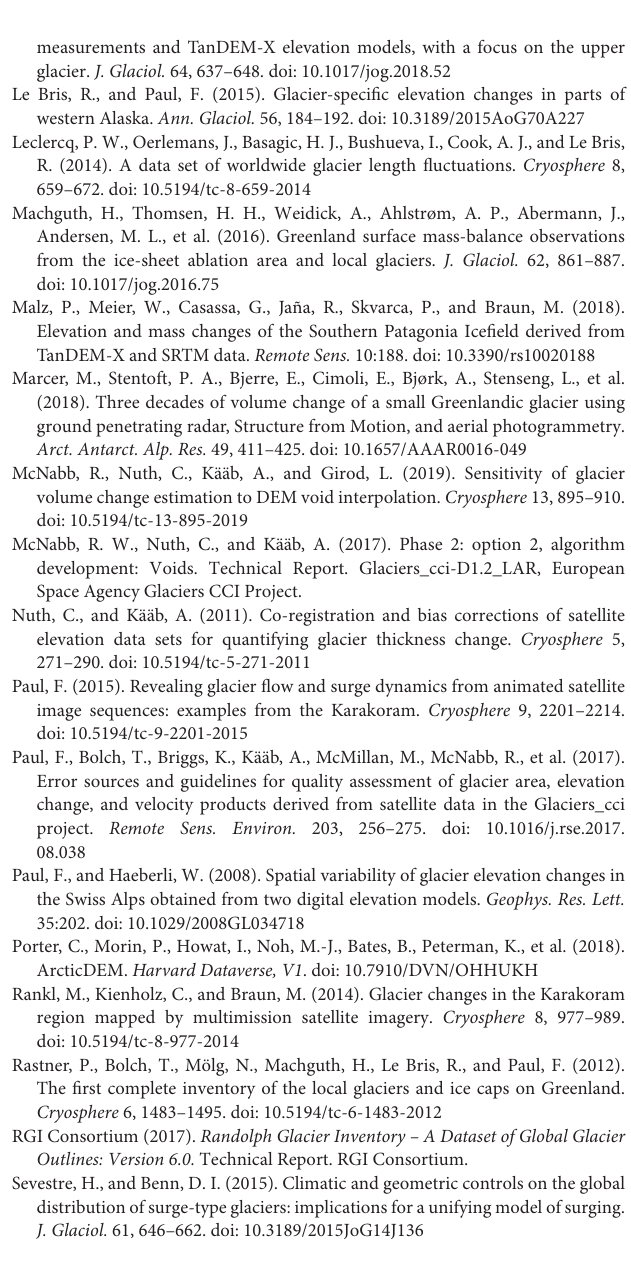
No artifacts visible. (B) AeroDEM (1985) with 25m resolution. Rectangular features in accumulation area are artifacts. (C) Reliability mask indicating areas of low data reliability (light yellow) laying over the AeroDEM. These areas declared as low data quality correspond with the artifacts visible in the DEM and hence are set to no data. Supplementary Figure 2 | General workflow to assess glacier-wide elevation changes for west-central Greenland 1985–2012 including the sources for the individual components of the uncertainty assessment. Supplementary Figure 3 | dDEM illustrating the elevation changes from 1985 to 2012 in the corresponding extract. Red and blue represent negative and positive elevation change values, respectively. White areas represent data voids. In black are the glacier outlines representing the state in 2001.